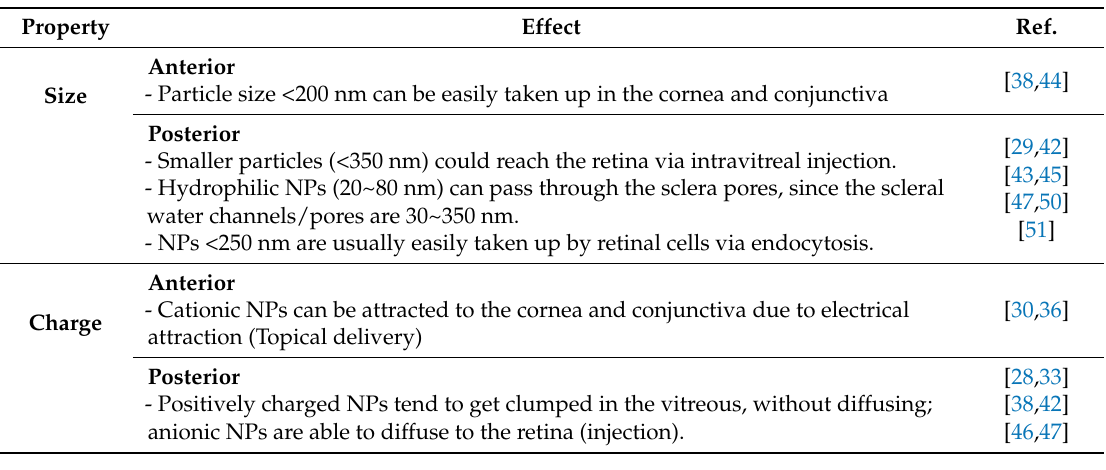
Table 1. Summary of physical properties of nanoparticles influencing its delivery region in the eye.